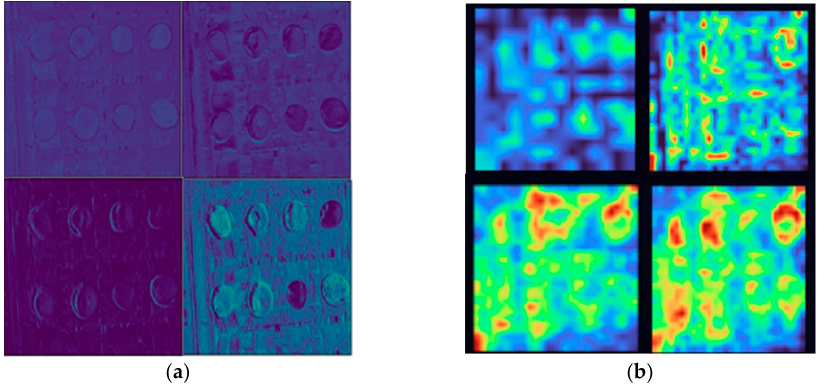
Figure 15. Feature map visualization of the Im-YOLOv5 model. ( a ) CSP network output 56 × 56 feature map; ( b ) SPP network output 14 × 14 feature map. Table 3. Comparison of different